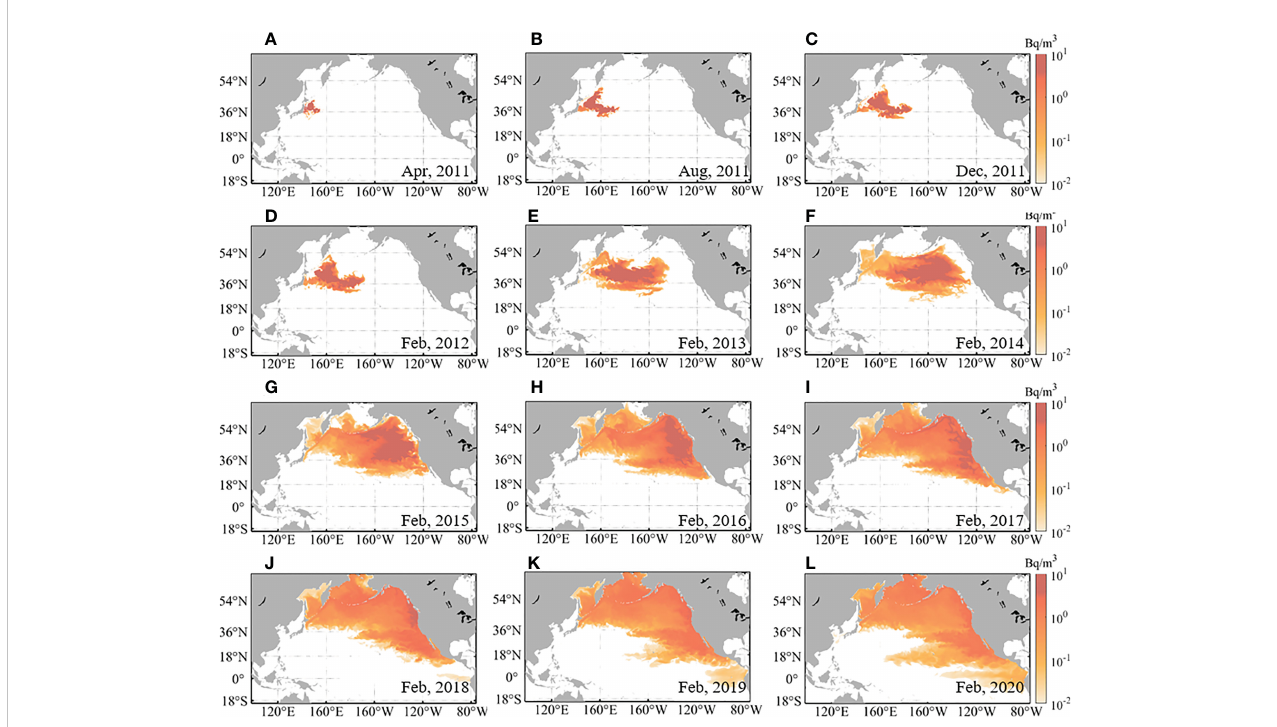
FIGURE 6 Monthly horizontal distribution of surface 137 Cs concentration from the model results in April (A – C) , August and December 2011 and each February (D – L) from 2012 to 2020. 137 Cs concentration was corrected for radioactive decay (30